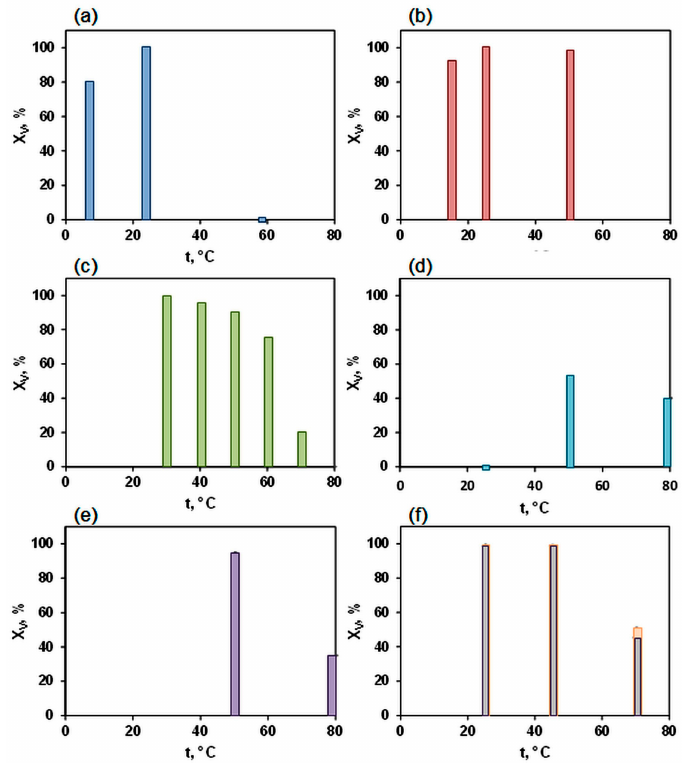
Figure 3. Influence of temperature on vaterite concentration in CaCO 3 samples; ( a ) L-L, S = 6.5, pH = 9, based on data from [21]; ( b ) with carbamate, [Ca 2 + ] = 1.5 M, based on data from [58]; ( c ) L-L, [Ca 2 + ] = 0.25 M, based on data from [24]; ( d ) L-L, [Ca 2 + ] = 0.015 M [73]; ( e ) L-L, [Ca 2 + ] = 0.015 M with ethylene glycol based on data from [73]; ( f ) G-L, pH = 9–10, x CO2 = 1, V G = 50 dm 3 /h (gray), V G = 100 dm 3 /h (orange) based on data from [59].